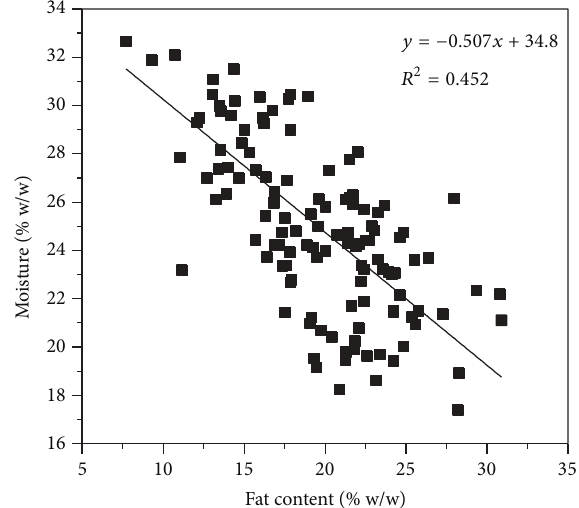
Figure 2: Plots of moisture content versus fat content of FBS.